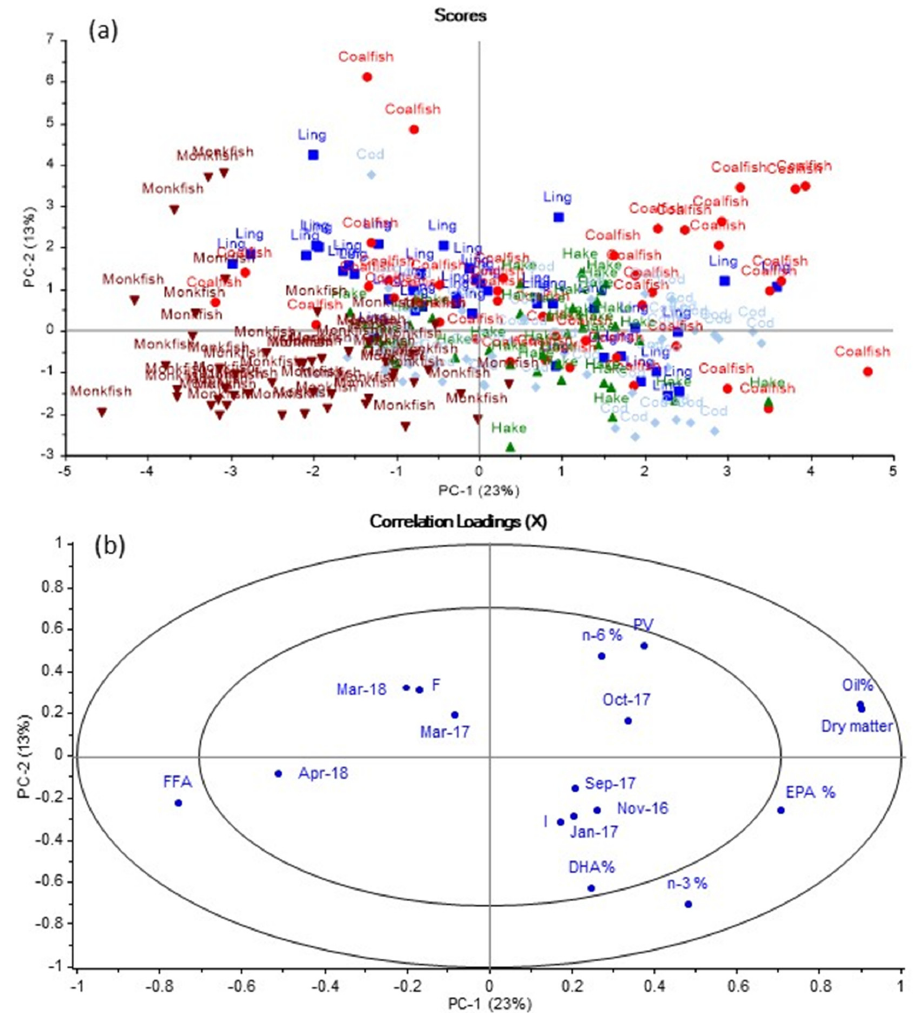
Figure 1. PCA plot for all fish species per month and the collected data for dry matter content, oil content, fatty acid composition, peroxide value and free fatty acid content. Data for July 2016 are not included in the PCA plots. ( a ) Scores plot of all the different samples and ( b ) loadings plot of variables including selected fatty acids, month of sampling and quality parameters. Variables located within the inner ellipse explain less than 50% of the variation in the data. Variables located between the two ellipses explain between 50% and 100% of the variation in the